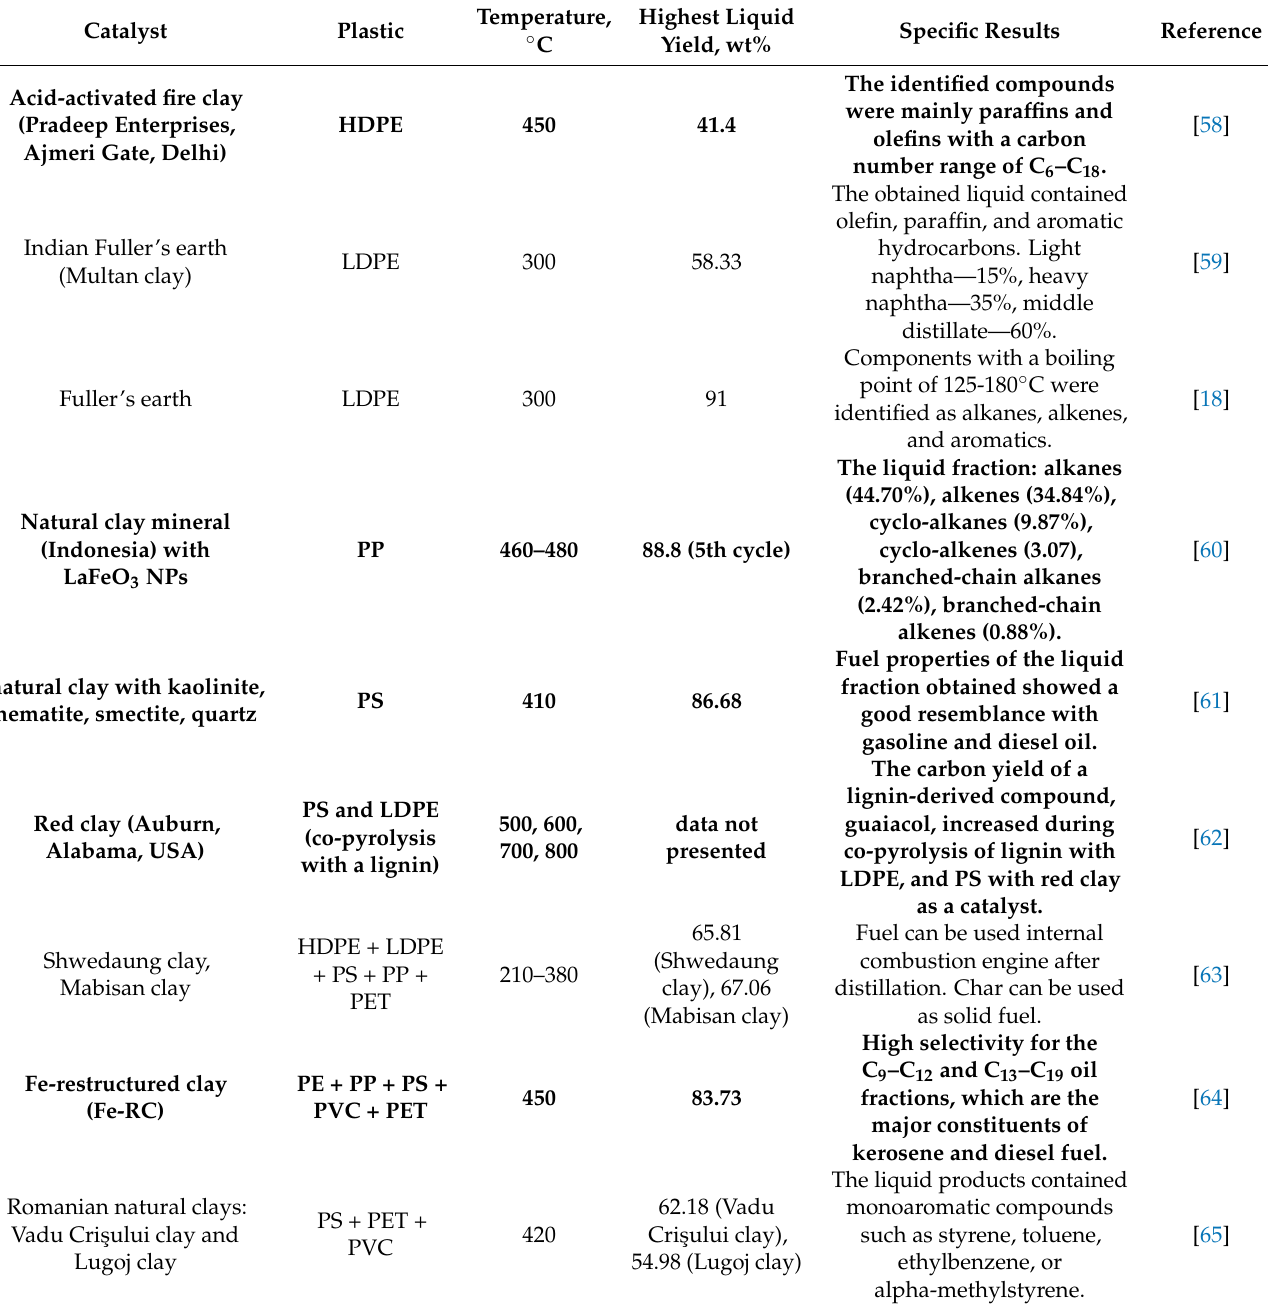
Table 4. Publications on the conversion of different plastics over clays from different